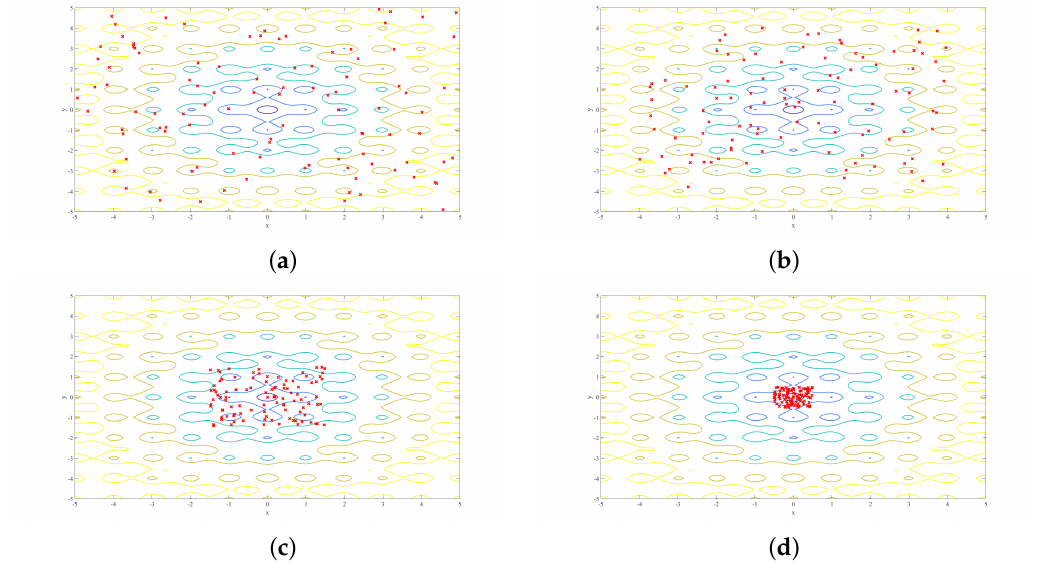
Figure 8. ( a ) Initial systems, ( b ) systems at iteration 17, ( c ) systems at iteration 34, and ( d ) systems at final